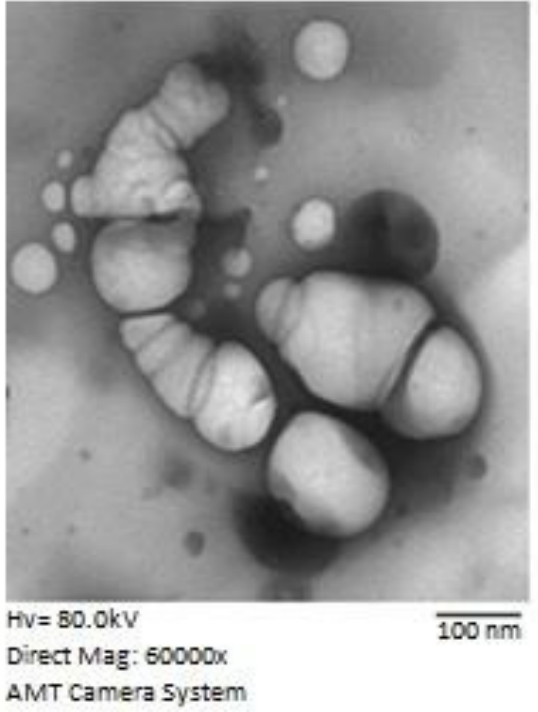
Figure 3. TEM image of the optimized CTD-GNE formula.